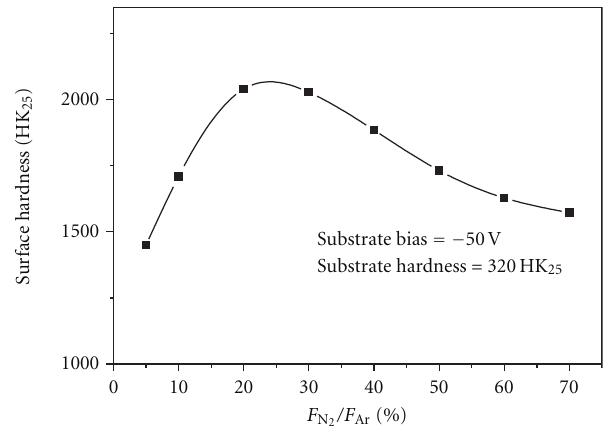
Figure 6: Surface hardness (at 25gf) of Nb-N coatings deposited on SS substrate at various F N − 50 − 50V).